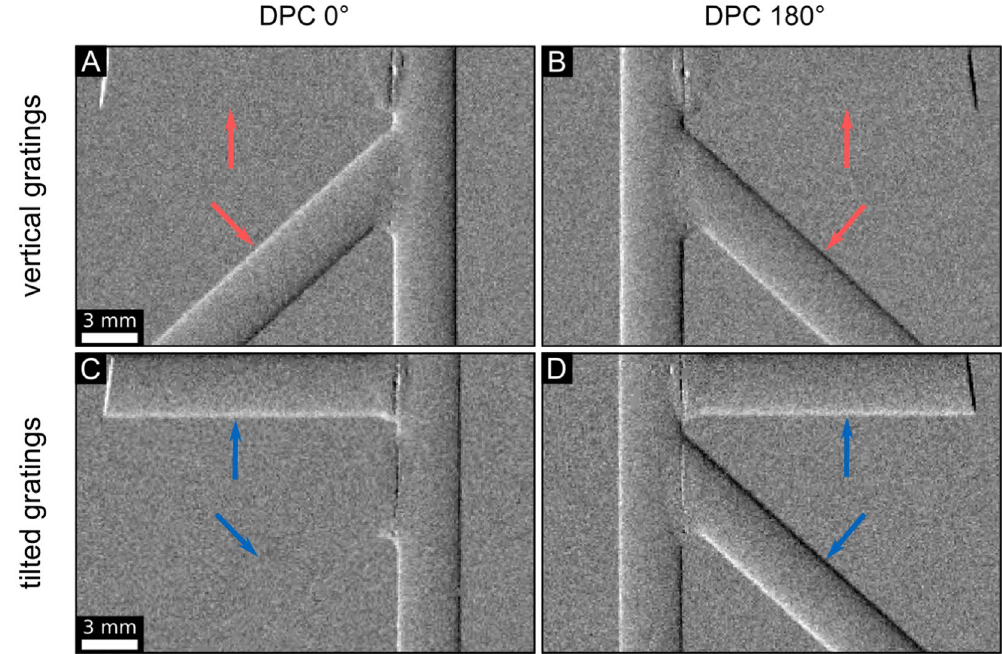
Figure 2. DPC projections of a phantom illustrating the grating sensitivity. The top row was measured with the vertical grating configuration, the bottom row with tilted gratings. Subfigures ( A ) and ( C ) depict the DPC signal of the phantom at 0°. Subfigures ( B ) and ( D ) show the same sample at 180° sample rotation with respect to the tomographic axis. The DPC signal of the full phantom shape is represented by subfigure ( D ). The colored arrows mark typical differences in sensitivity at the same rotational position arising from the different grating orientation. The gray scale of the lateral phase-shift of the interference pattern ϕ is in the linear range of [ − 0.4,